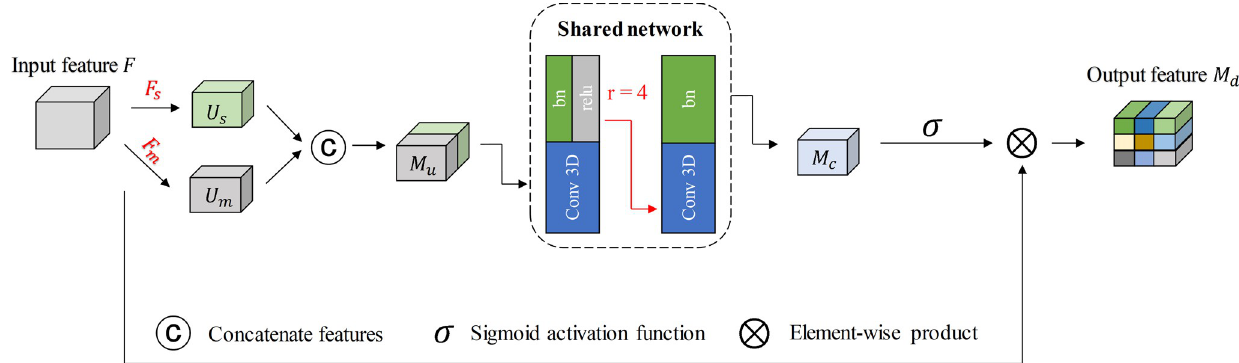
Fig 3. Diagram of our PA module. Given the feature f , PA generates parallax weights by fusing average and maximum values in disparity dimension.